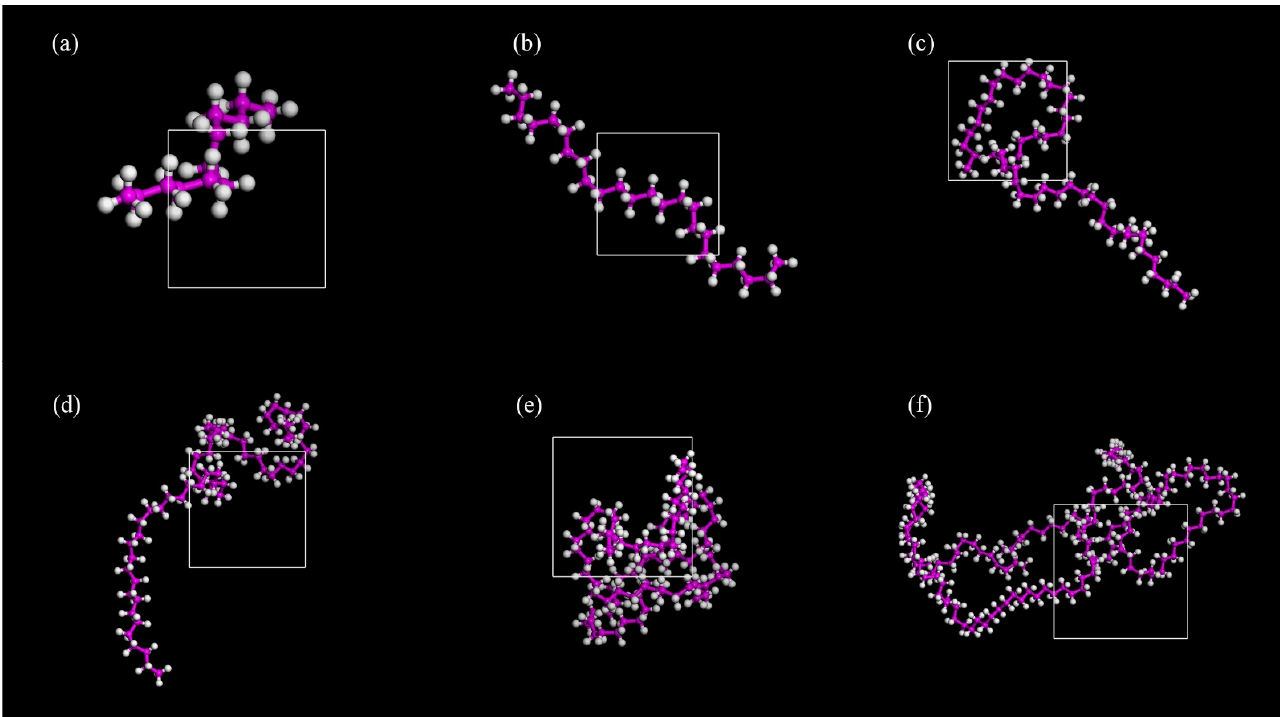
Figure 6. PE molecular model with different degrees of polymerization ( a ) 6 ( b ) 12 ( c ) 24 ( d ) 30 ( e ) 42 ( f ) 78.